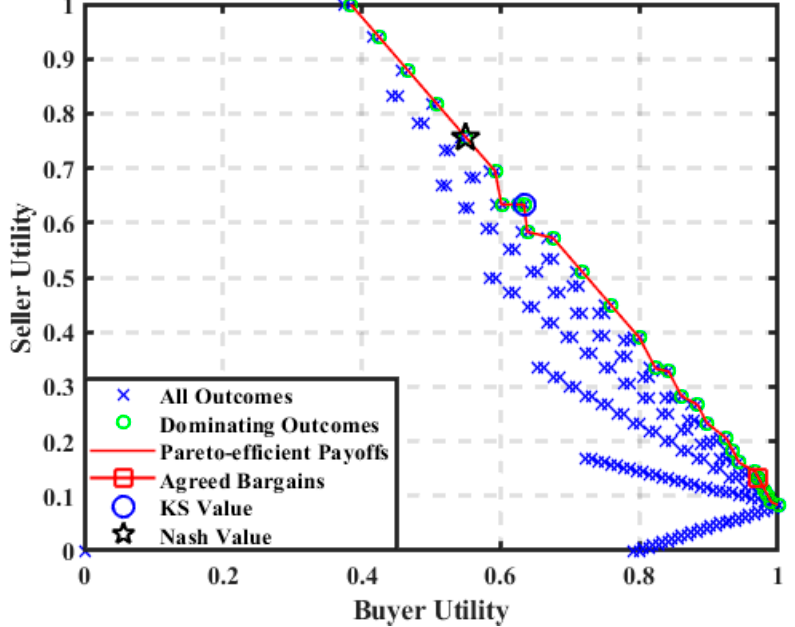
Figure 5. Automated negotiation possible outcomes space for seller and buyer 3 (Tier 1) expert agents.